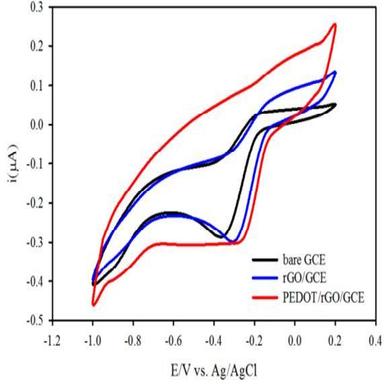
V of ORR of modified electrode in 0.1 M of KOH solution.